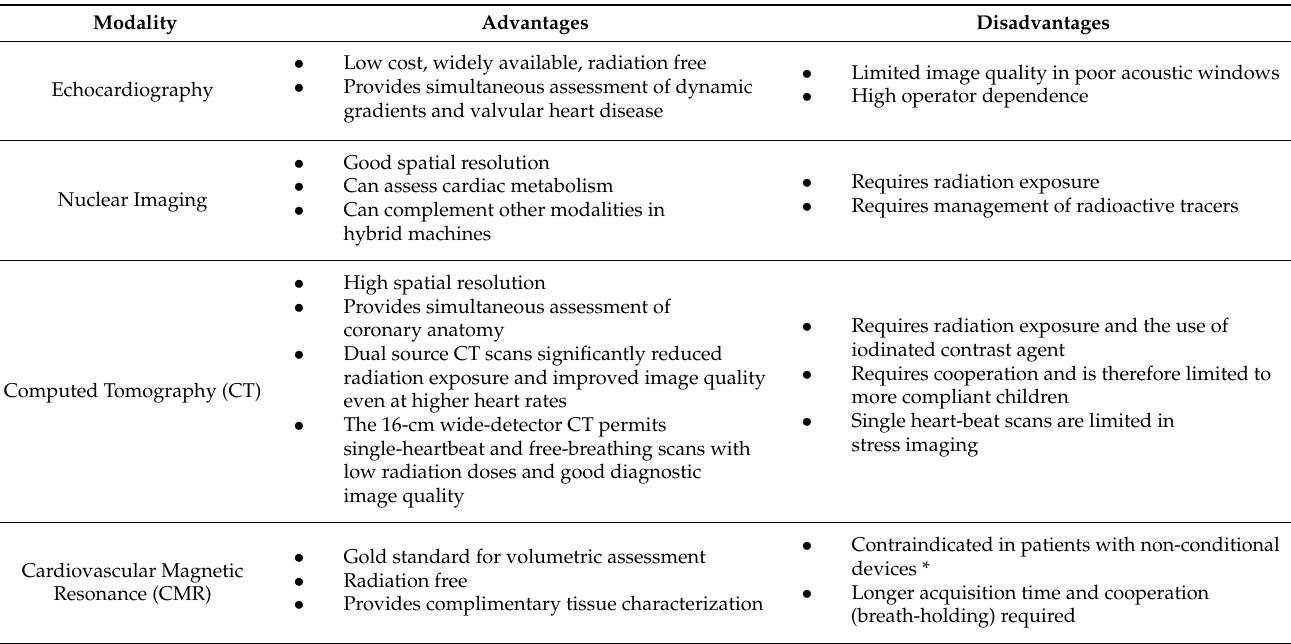
Table 1. Advantages and disadvantages of each cardiovascular imaging method. * Unless performed in expert centers where non-MRI conditional devices are performed in